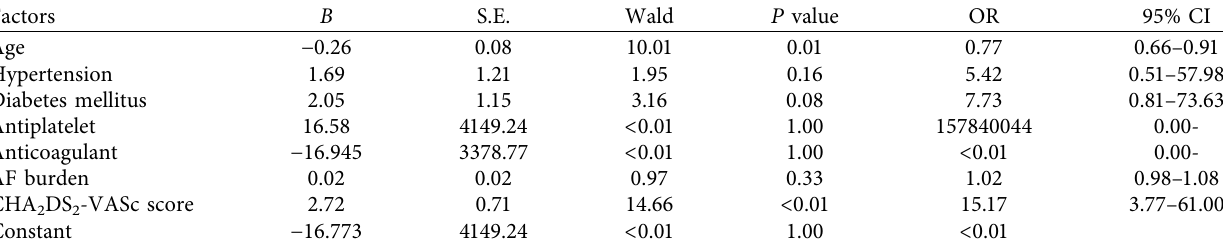
Table 3: Binary logistic regression analysis of stroke event.